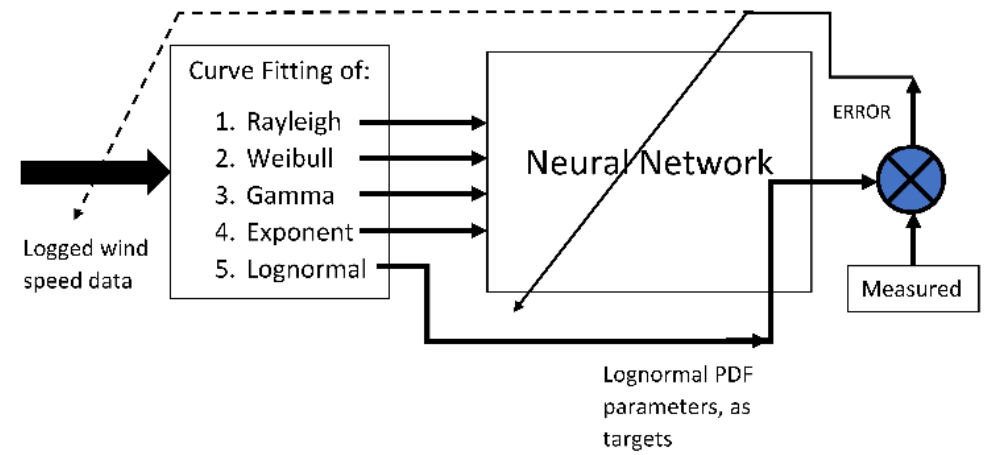
Figure 6. Algorithm of implemented neural network, showing curve fitting analysis and a feedfor- ward 5-layer back propagation network. Error from measurements can tune up the NN coefficients.